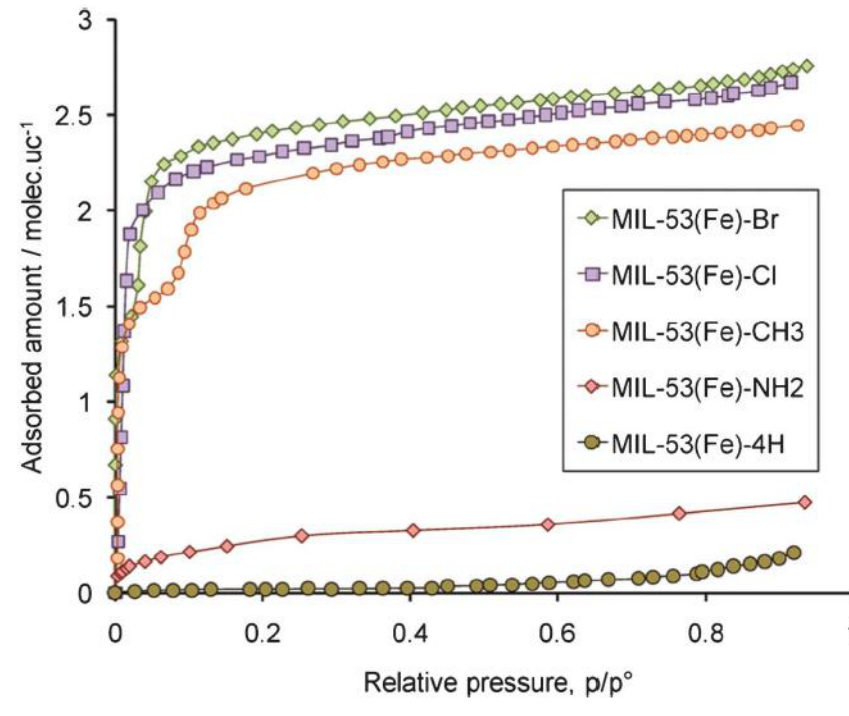
Figure 12. Adsorption isotherms of n -hexane of various modified MIL-53(Fe). MIL-53(Fe)-4H stands for the non-modified MIL-53(Fe). Reprinted with permission from [101]. Copyright 2011 American Chemical